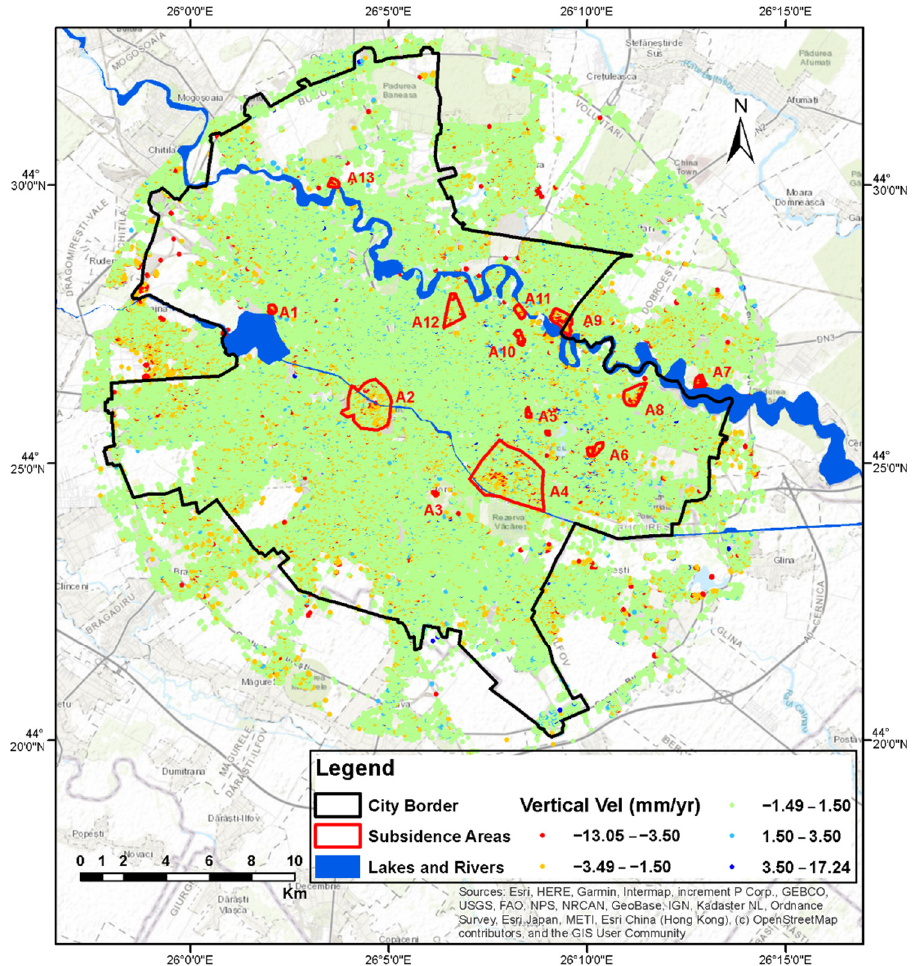
Figure 4. PSI map of vertical land displacements in Bucharest city (obtained from Sentinel-1 images) and the identified subsidence areas (modified after [38]). Map generated in Esri ® ArcMap™ 10.3. Source: elaborated by the authors. Table 2. Areas with identified displacements (modified after